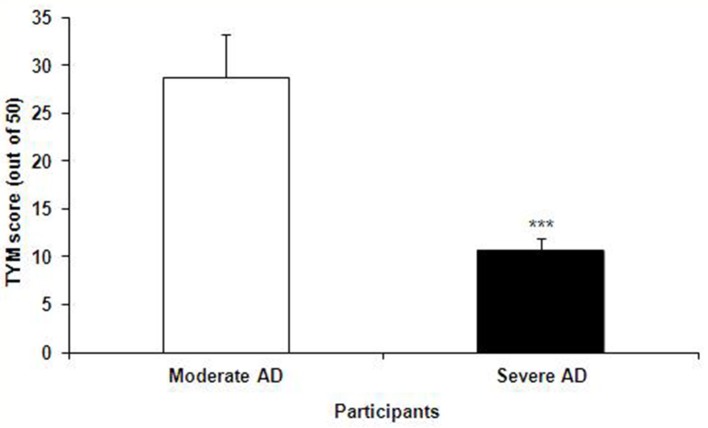
The TYM scores achieved by the patients with moderate and severe Alzheimer's disease (AD); the former group gained 28.7 ± 4.47 score and the latter 10.63 ± 1.35 score. Unpaired student t-test showed a significant difference between the two AD groups (***P < 0.0001).